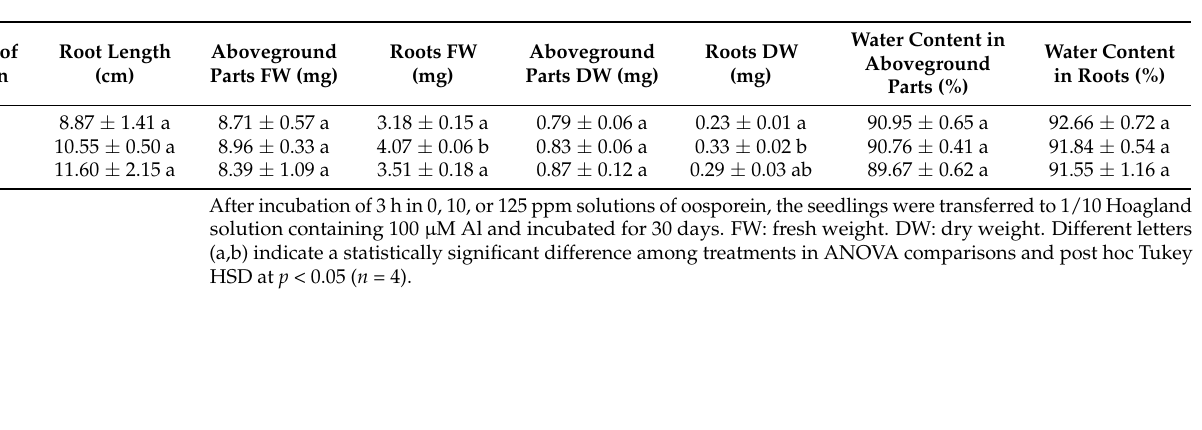
Table 1. Seedling growth of Miscanthus sinensis in liquid culture containing 100 µ M Al after oosporein